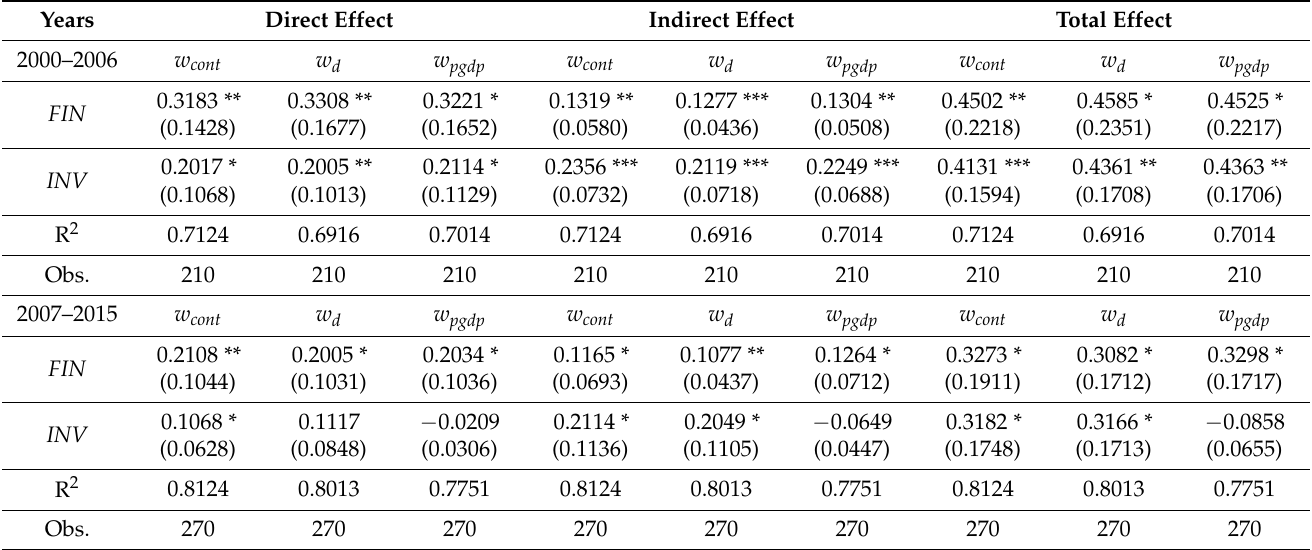
Table 5. Time segment estimation results of the full sample.